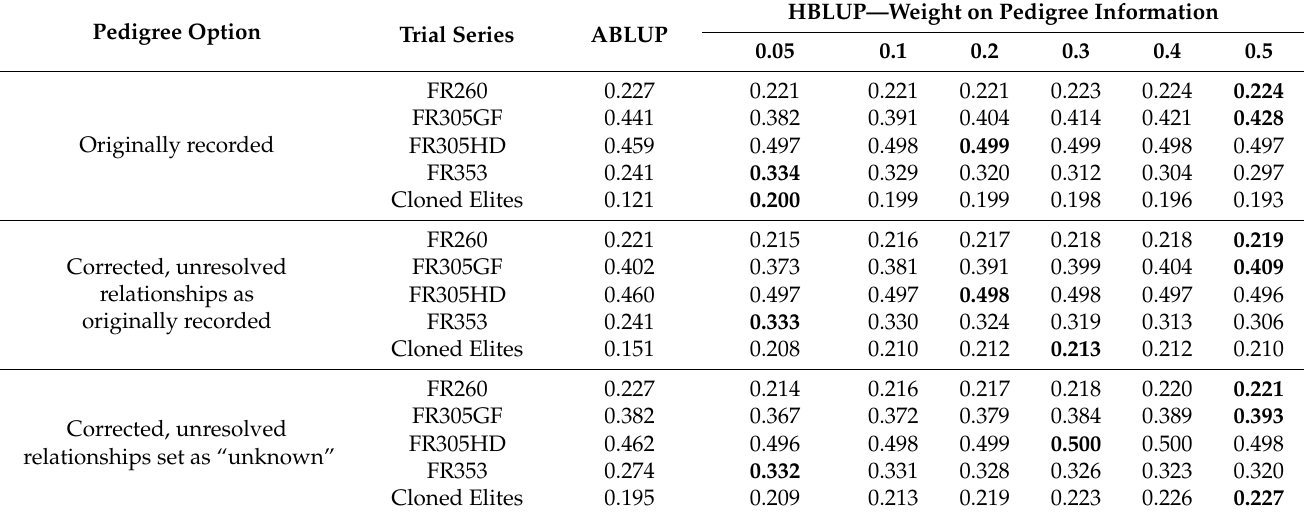
Table 3. Predictive abilities for pedigree-based (ABLUP) versus single-step blended (HBLUP) predic- tion analyses for diameter at breast height (DBH). Results from the best HBLUP model are shown in bold. Cross-validations were performed by including all but one trial series in the training set, with the remaining trial series used as a test set (see Materials and Methods).